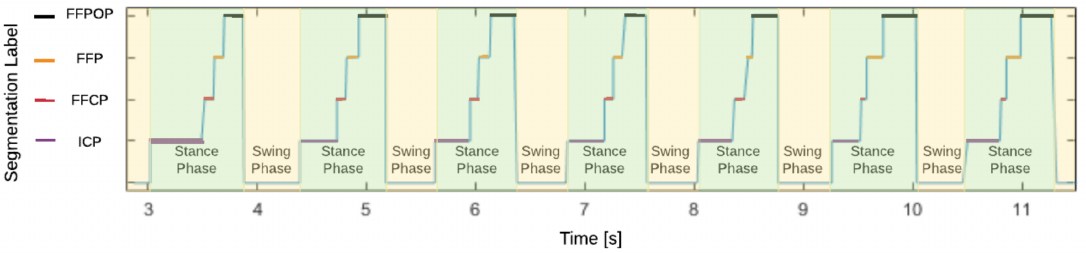
Figure 9. Example of the achieved segmentation of phases and subphases for one volunteer.